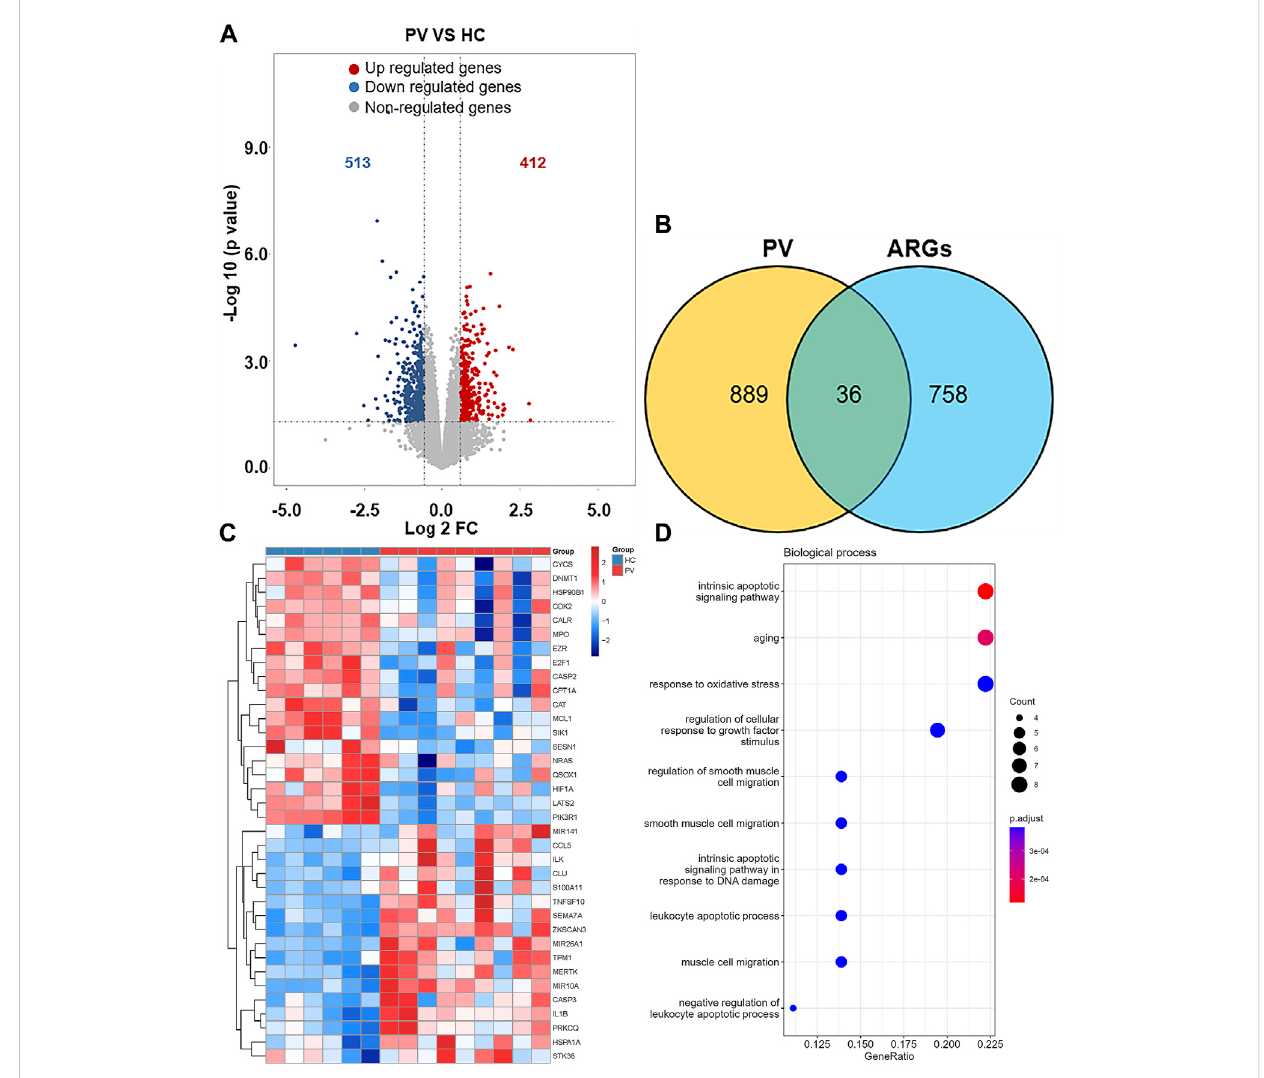
FIGURE 5 Landscape of Anoikis-related Genes in Polycythemia Vera. (A) Volcano plot of genes differentially expressed between Polycythemia Vera (PV) patients and healthy controls in the GSE136335 dataset. Blue nodes represent downregulation in PV; red nodes represent upregulation; and grey nodes representnosigni fi cantdifferencefromcontrols. (B) Intersectionofdifferentiallyexpressedgenes(DEGs)intheGSE136335andanoikisgenes.Thecount ontheleft(889 genes)referstoDEGsuniquetoGSE136335;thecount inthemiddle(36 genes)referstoanoikis-relatedDEGs;andthecountonthe right (758 genes) refers to unique to anoikis genes. (C) Heat map of 36 anoikis-related DEGs. (D) Top 10 GO biological process